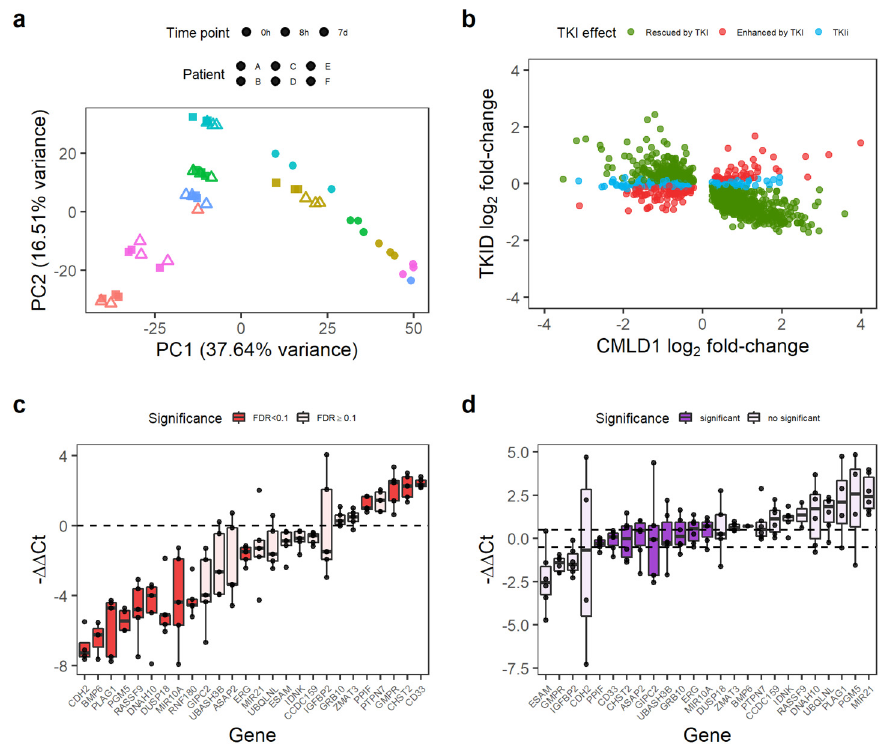
Figure 2. Some genes differentially expressed in CML LSC are not affected by TKI treatment. ( a ) PCA of the TKID dataset. Interpatient variability and treatment (7 d vs. 0 h/8 h) seem to have a major contribution to the variance of the dataset. Each point represents one microarray. ( b ) Correlation of gene expression log2 fold-changes between TKID and CMLD1. Although most genes show a negative correlation after 7 d of TKI treatment compared with CML vs. Normal (normal expression “rescued by TKI”), a minority of genes were not affected by TKI treatment (TKI independent or TKIi), and some genes were further deregulated into the same direction than in CML vs. Normal (“enhanced by TKI”). ( c ) Gene expression differences between CML-CP CD34 + cells and normal CD34 + cells as measured by qPCR. Each dot represents the relative expression of one CML sample compared with the mean expression of the normal samples for each gene. Differential gene expression was calculated with limma , and an FDR < 0.1 was considered significant. ( d ) Gene expression differences between CML-CP CD34 + cells treated with 5 µ M IM (7 d) and NDC (7 d). Relative gene expression was calculated per patient (paired-analysis), and a mean log2 fold-change (or ∆∆ Ct) between − 0.5 and 0.5 was considered significant no change. Each dot represents a patient.